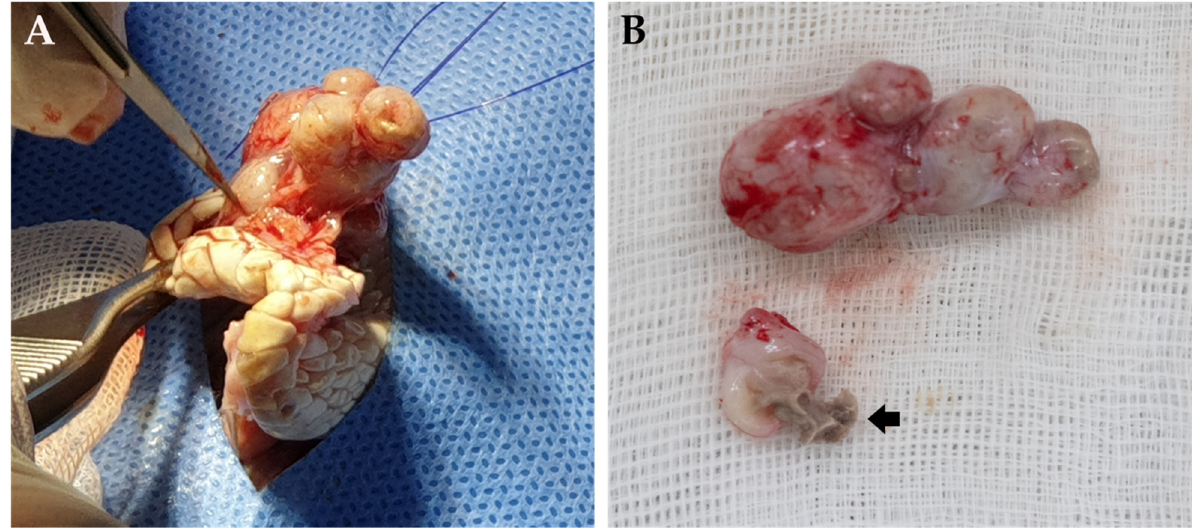
Figure 3. Gross examination of the mass after surgical removal. ( A ) Multinodular appearance of the mass. ( B ) Pus visible (arrow).